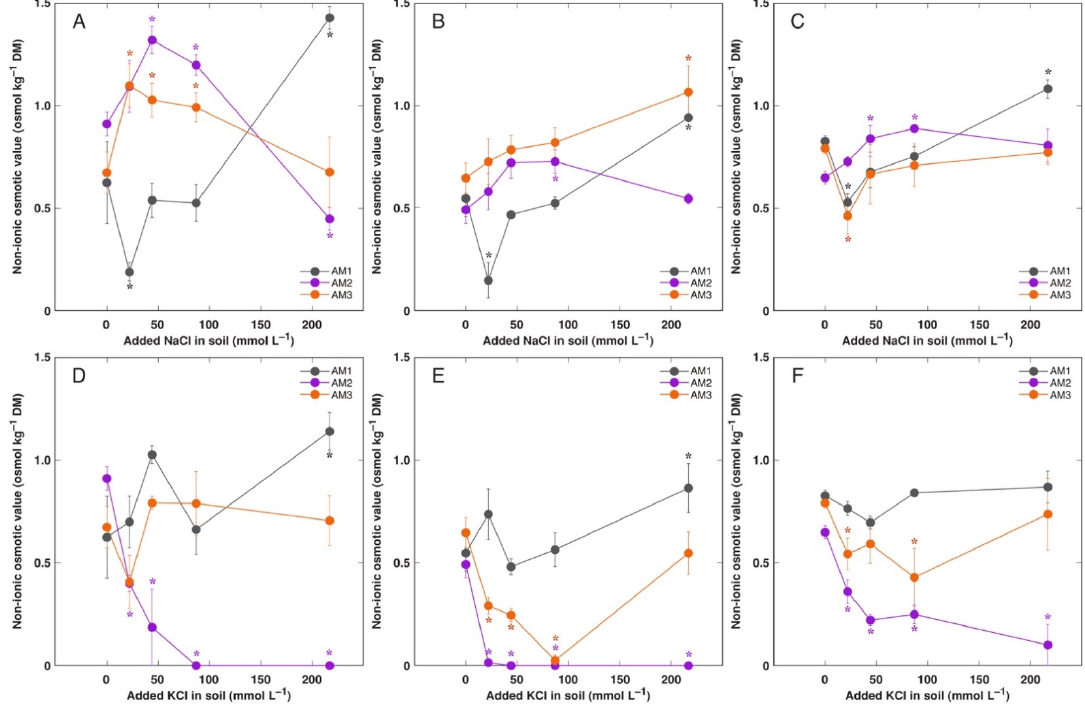
Figure 10. Effect of added NaCl ( A – C ) and KCl ( D – F ) concentration in soil on non-ionic osmotic value in old leaves ( A , D ), new leaves ( B , E ) and flowers ( C , F ) of Armeria maritima plants from different accessions after 7–8 weeks of cultivation. DM, dry mass. Data are means ± SE from 3 replicates. Asterisks of respective color indicate statistically significant differences ( p < 0.05) from control. Relationships between summed Na + + K + concentration and osmotic value in tissues confirmed differences in osmotic regulation between NaCl and KCl treatments in plants from accession AM2 and, partially, for AM3 (Figure 11).